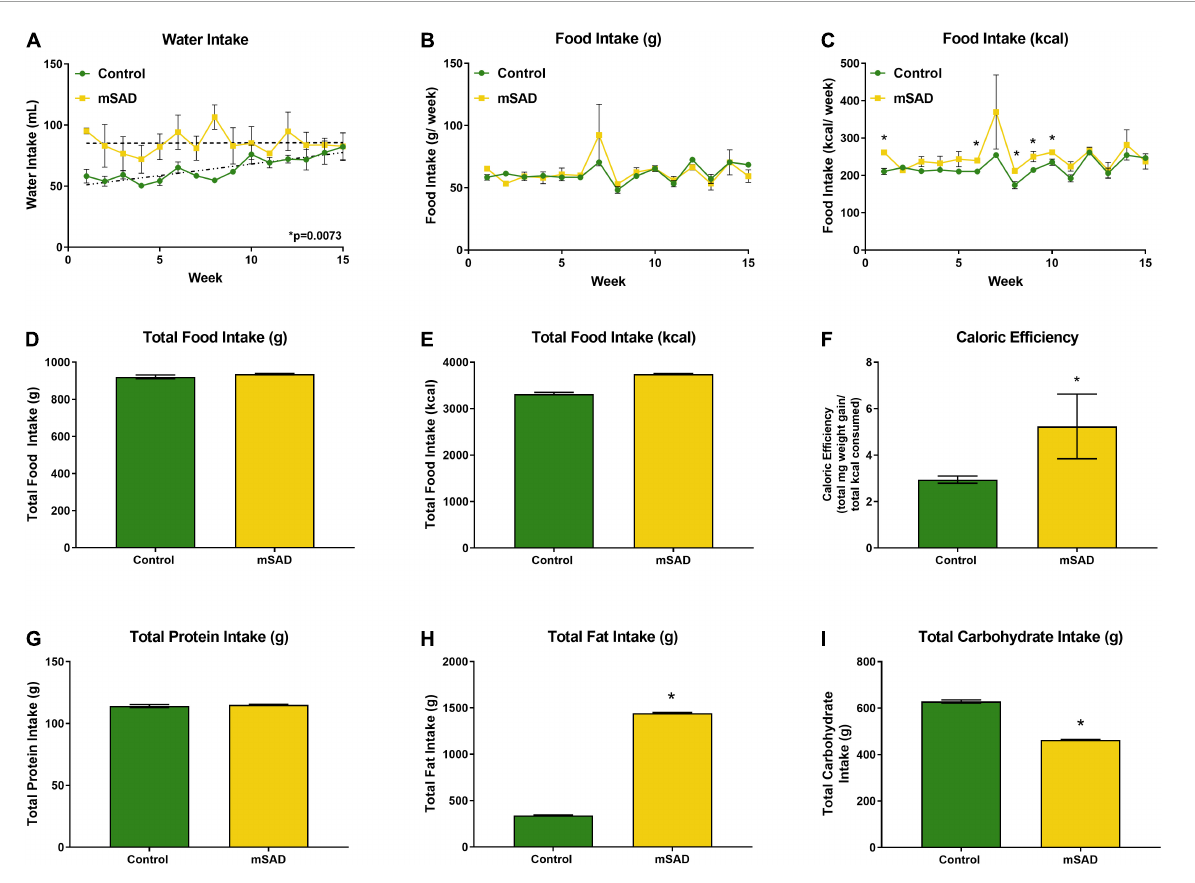
FIGURE2 Water, food, and macronutrient intake. All values represent average cage intake ( n = two cages, each containing three mice). Water intake was measured as mL per cage per week (A) . Food intake was measured as g per cage per week by a subtractive method of weekly provision minus weekly remnants (B) and kcal consumed per week (C) . Total food intake (g) (D) and kcal consumption (E) for the 15-week period. Caloric efficiency for each diet was calculated as total mg weight gain/total kcal consumed for the 15-week period (F) . Total protein (G) , lipid (H) , and carbohydrate intake (I) were calculated. Values are represented as mean ± SEM. Data were compared using Welch’s t -test. * p <